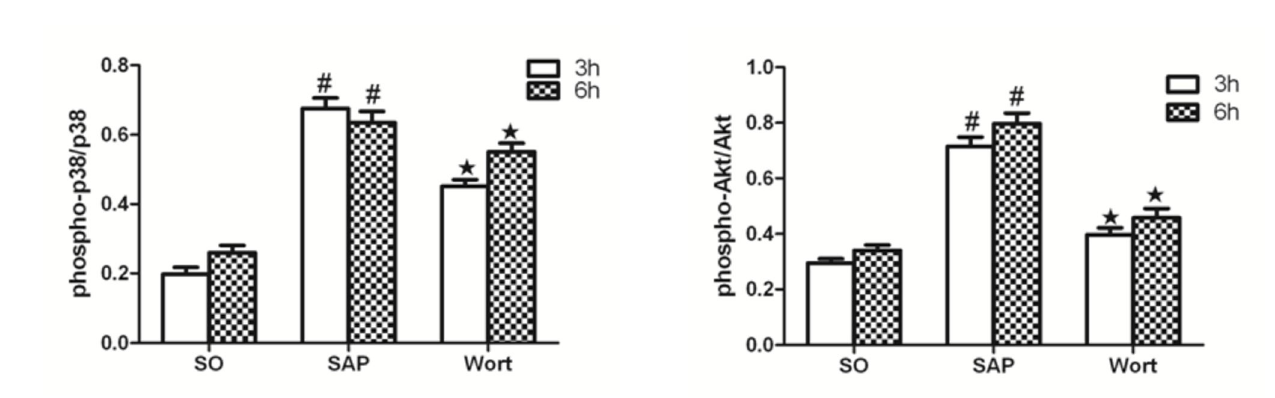
Figure 12. p-Akt/Akt protein expression in each group at the 3 h and 6 h time point. # P <0.05 vs. SO group; ★ P <0.05 vs. SAP group. doi: